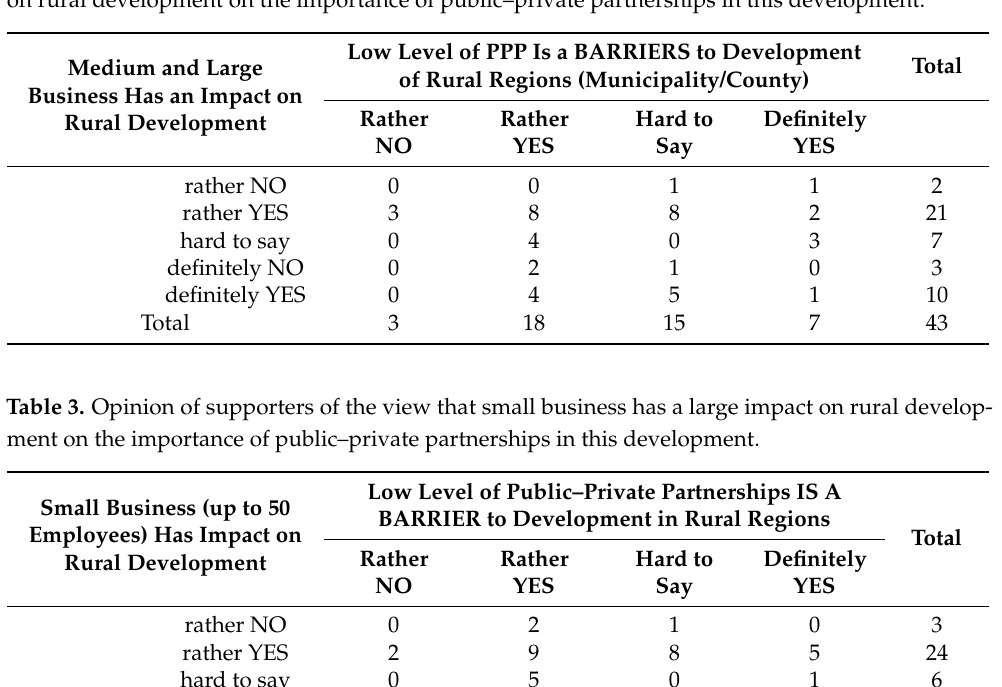
Table 2. Opinion of supporters of the view that medium and large business have a strong influence on rural development on the importance of public–private partnerships in this development.